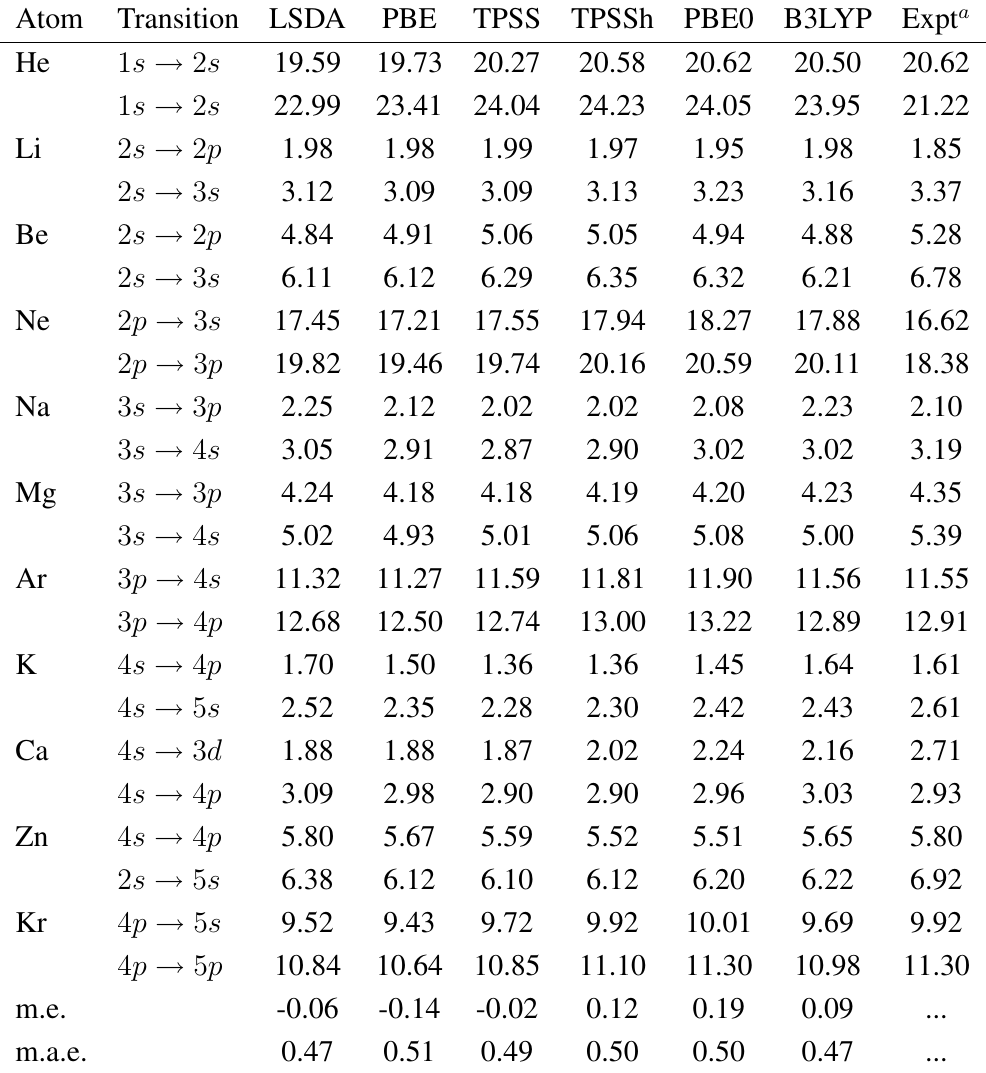
Table 1. Two lowest-lying singlet excitation energies (in eV) of atoms calculated using six functionals with the basis set 6-311++G(3df,3pd). The mean error (m.e.) (with the sign convention that error = theory - experiment) and the mean absolute error (m.a.e.) are also shown. The mean experimental value of these atoms is 8.06 eV. (1 hartree = 27.21